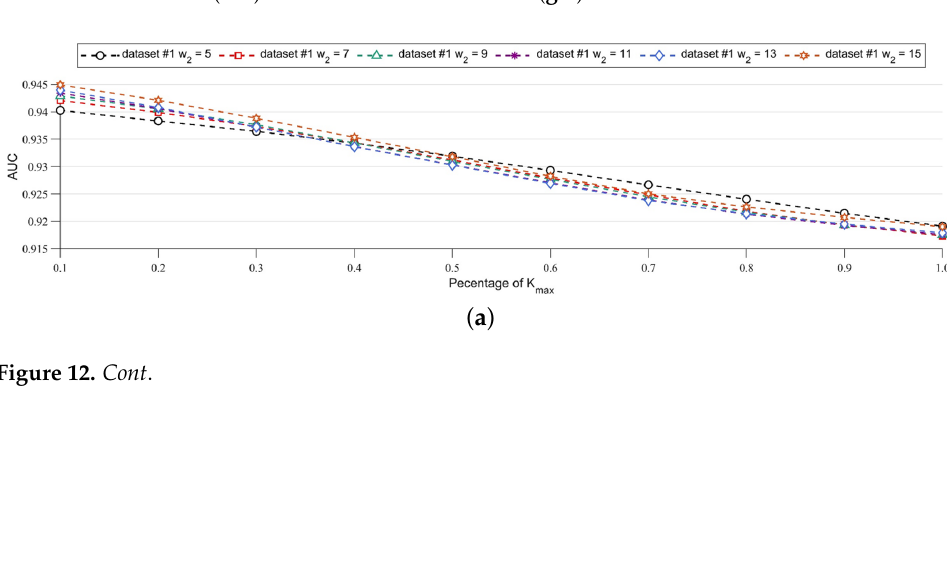
Figure 11. The ROC curves of the SNLSW detector with different K on Datasets #1/2/3. ( a – c ) ROC curves on Dataset #1. ( d – f ) ROC curves on Dataset #2. ( g – i ) ROC curves on Dataset #3.